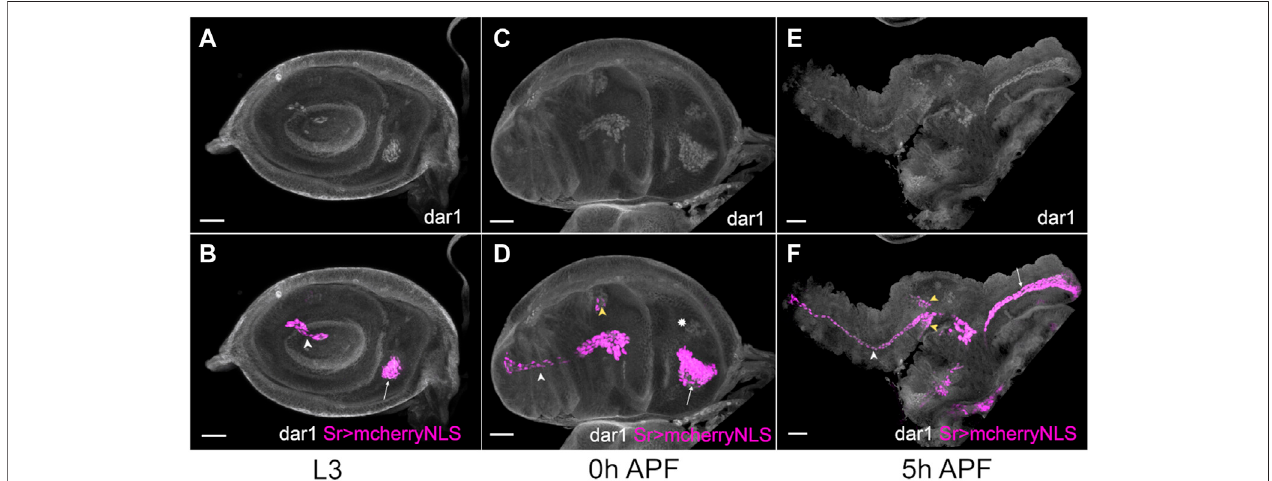
FIGURE. 2 | dar1 expression pattern co-localizes with stripe expression in Drosophila leg disc. Selected optical sections of sr-gal4 > UAS-mcherryNLS (magenta) leg discsimmunostained withanti-Dar1(gray) at different stepsofdevelopment (A,B) InL3 leg disc, dar1 and mcherryNLS expressions colocalizeincells pre fi guringthe future lt in the tarsi (white arrowhead) and the future tilt in the dorsal femur (arrow). This co-expression is maintained at 0 h APF (C,D) and 5 h APF (E,F) in elongating tendons, whereas newly-speci fi ed sr > mcherry-positive cells, in tibia segment notably, also start to express dar1 (yellow arrowheads). Note that dar1 is also expressed at a low level in the apparent chordotonal organ at 0 h APF (asterisk). Scale bar 30 μ